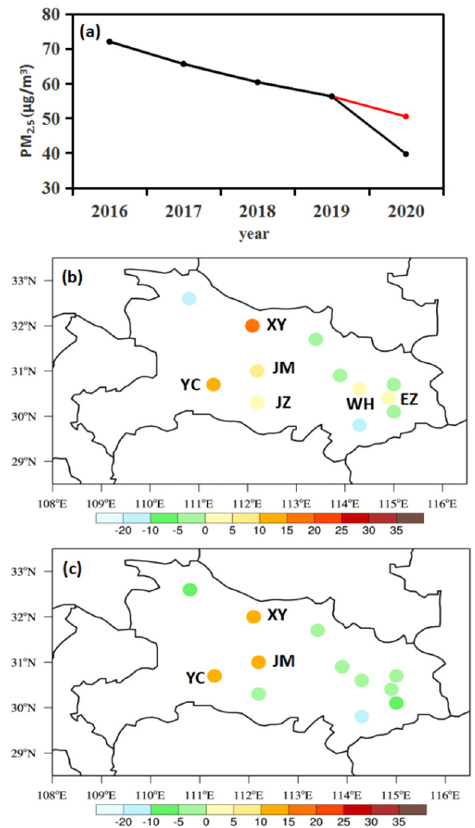
Figure 2. Changes in particulate matter smaller than 2.5 μ m (PM 2.5 ) during the coronavirus disease 2019 (COVID-19) outbreak in Hubei Province. ( a ) The February–March average concentration (black dot) during 2016–2020 (the red dot represents the value for 2020 calculated based on the 2016–2019 linear fitting trend), ( b ) spatial anomaly of the average PM 2.5 concentration in Hubei Province from February to March in 2016–2019, and ( c ) spatial anomaly of average the PM 2.5 concentration in Hubei Province during the COVID-19 pandemic.